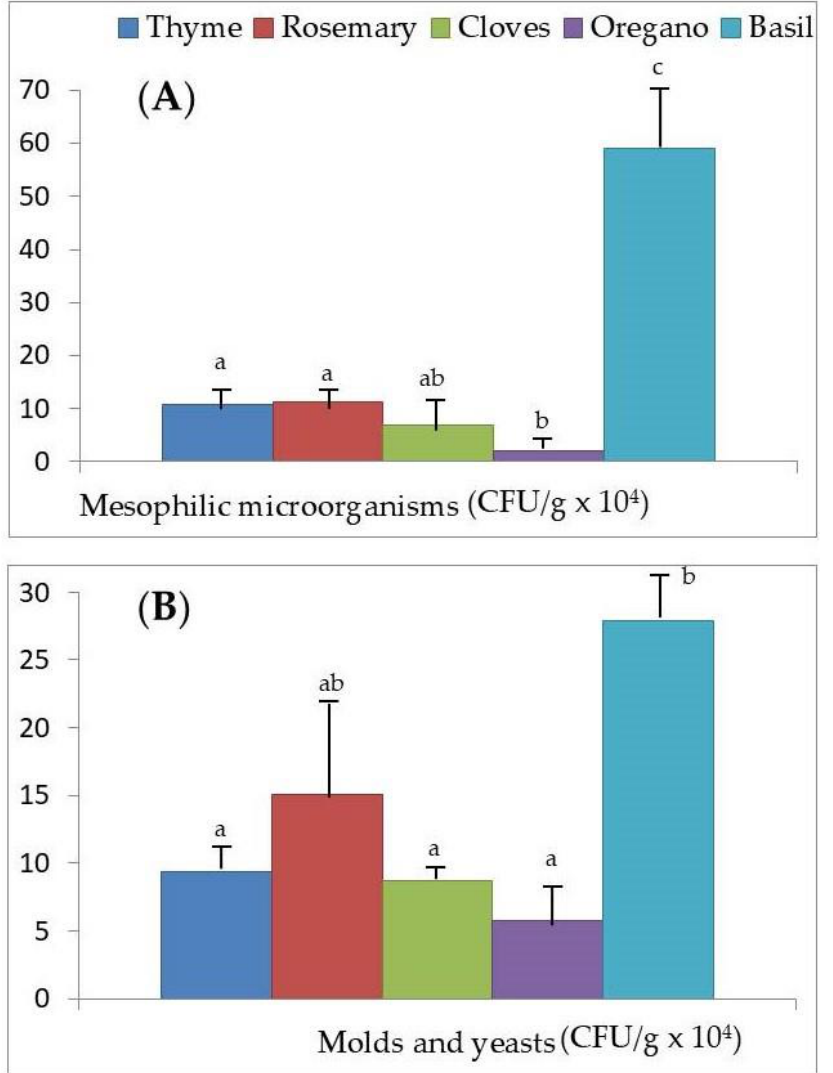
Figure 4. Microbial counts measured as colony forming units (CFU/g) for ( A ) mesophilic microorganisms and ( B ) molds and yeasts after the addition of the dehydrated aromatic herbs (thyme, rosemary, cloves, oregano, and basil) to the culture medium. a,b,c,d,e Mean microbial counts; different superscripts indicate significant differences between the aromatic herbs ( p < 0.001).